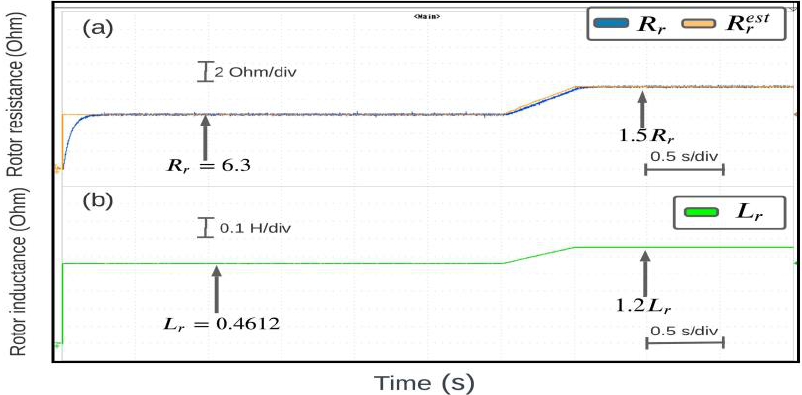
Figure 16. The rotor parameters ( a ) rotor resistance; ( b ) rotor inductance.